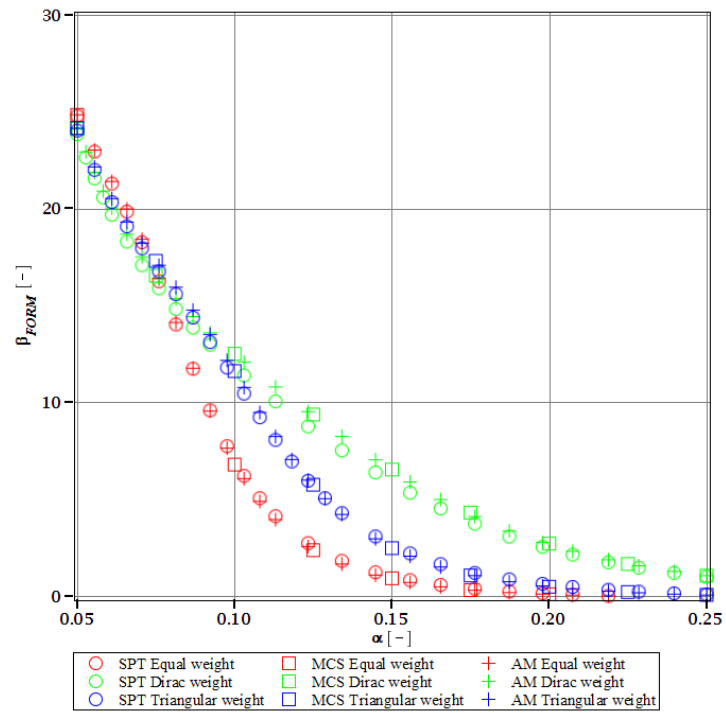
Figure 16. Reliability index of the corrugated I-beam for different types of weights according to the first-order reliability method (FORM) — critical load.